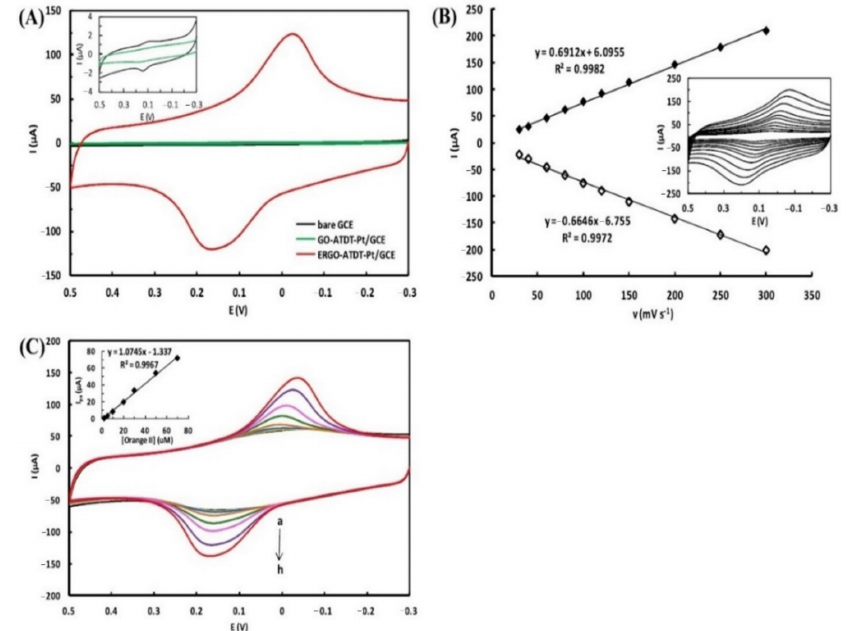
Figure 4. ( A ) The cyclic voltammograms of bare glassy carbon electrode (GCE), 5-amino-1,3,4- thiadiazole-2-thiol-Pt/glassy carbon electrode (ATDT-Pt/GCE), and electrochemically reduced graphene oxide-5-amino-1,3,4-thiadiazole-2-thiol-Pt/glassy carbon electrode (ERGO-ATDT-Pt/GCE) in 50 µ M at a scan rate of 100 mV/s; ( B ) the plot of redox peak current vs. scan rate in presence at 30–300 mV/s; ( C ) CV at different concentrations of the orange II dye (0, 2, 5, 10, 20, 30, 50, and 70 µ M) Reprinted (adapted) with permission from Ref. [61]. Copyright 2015, Elsevier.